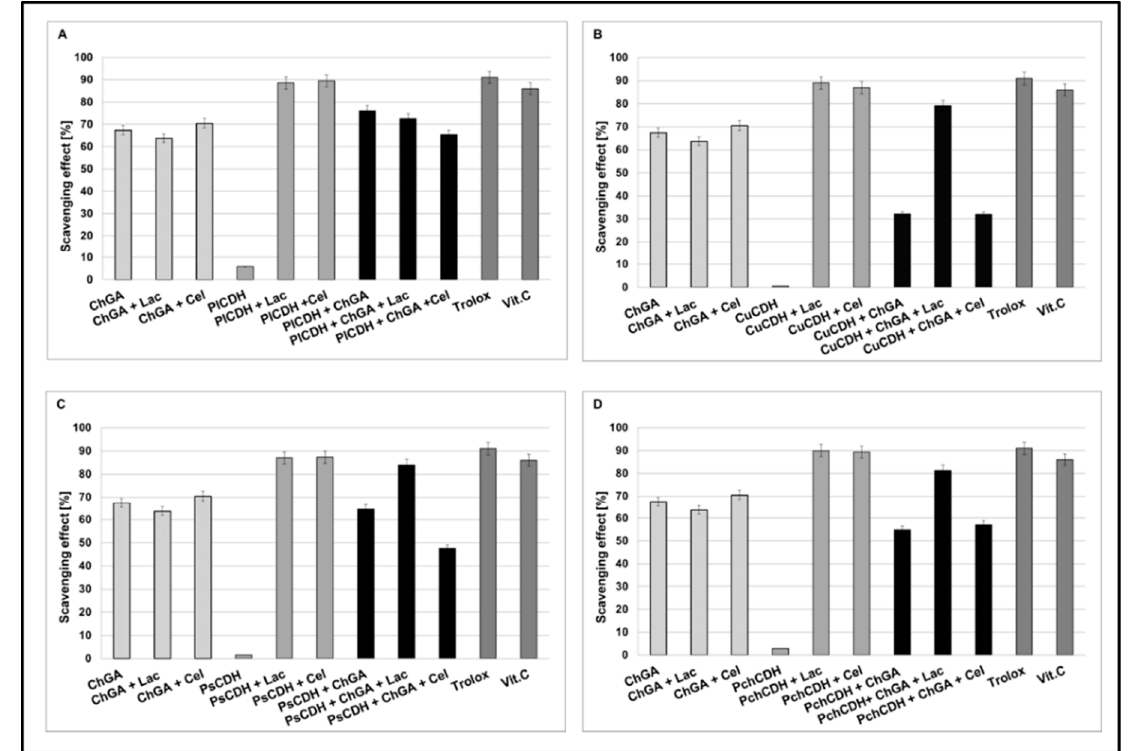
Figure 4. Scavenging effects of chitosan beads with glutaraldehyde (ChGA) (C1-control) with lactose ChGA + Lac (C2-control), or cellobiose ChGA + Cel (C3-control) containing CDHs isolated from Phlebia lindtneri (Pl CDH) ( A ), Cerrena unicolor (Cu CDH) ( B ), Pycnoporus sanguineus ( Ps CDH) ( C ) and Phanerochaete chrysosporium (Pch CDH) ( D ). Data are mean ±SD for three measurements (n = 3).